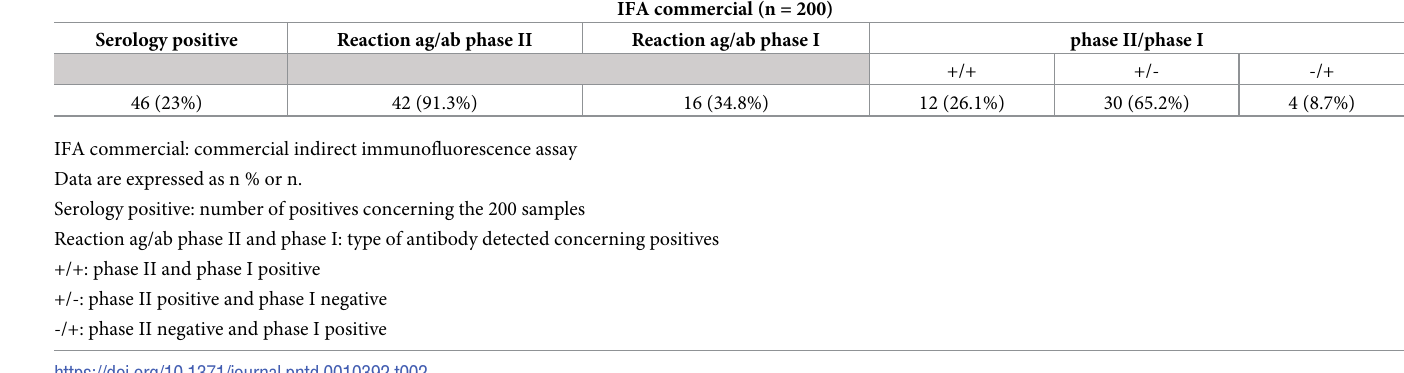
Table 3. Distribution of Q fever seropositivity according to the titer and type of antibody (ab).